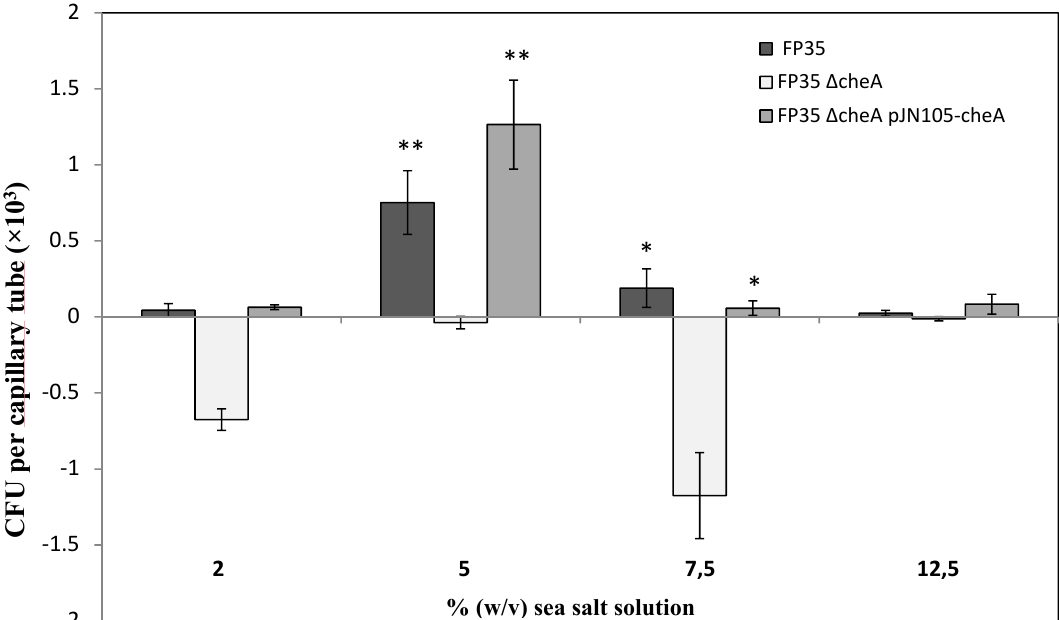
Figure 2. Quantitative capillary chemotaxis assays comparing responses of wild-type H. anticariensis FP35 T and mutant strains FP35 ∆ cheA and FP35 ∆ cheA pJN105-cheA to root exudates grown at different % (w/v) sea salt solution concentrations. The results represent the mean of three independent biological samples performed in triplicate, with error bars indicating standard errors. The graph shows the increase in CFU in capillaries normalized by the negative control (CB). The negative CFU values in the capillaries reflect negative chemotaxis. Comparison of different strains tested using the Tukey test (* p ≤ 0.05; ** p < 0.01).